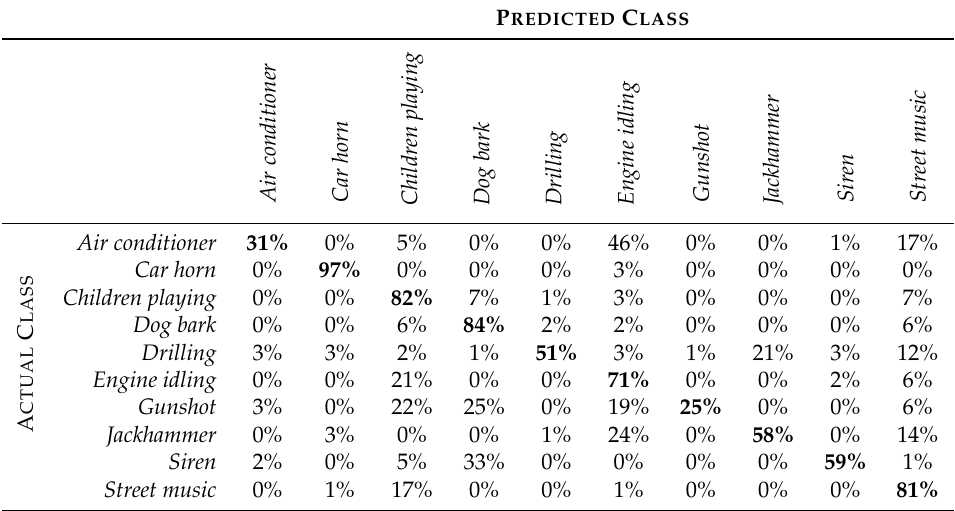
Table 4. Confusion matrix considering the classification of the modified audio files in a network of four